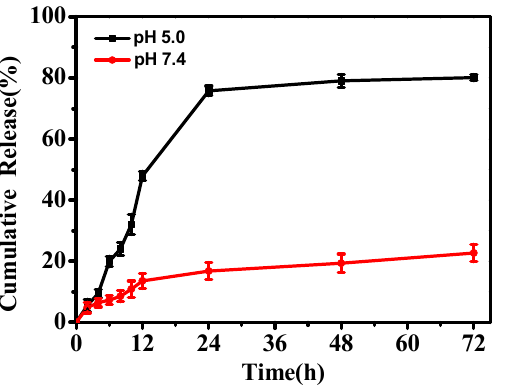
Figure 3. The in vitro release curves of glabridin from Gla-ZIF-8 in PBS (pH 7.4 and 5.0).